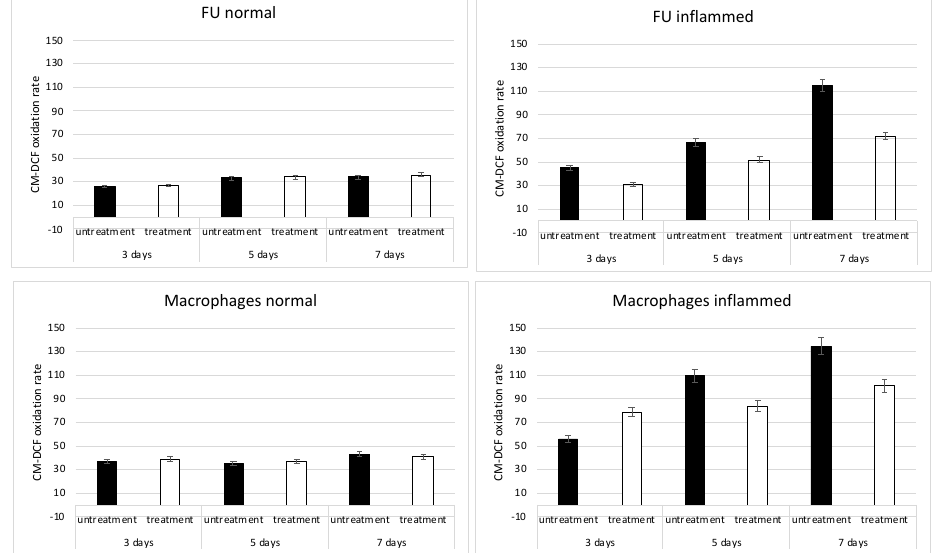
Figure 2. Effects of inflammation on the mitochondrial physiology evaluated by means of the oxidation process activation in fibroblast (FU), inflamed or not, and in macrophages, inflamed or not, in the presence of the CMF treatment (white bars) or in absence (untreated, black bars) with the CMF.